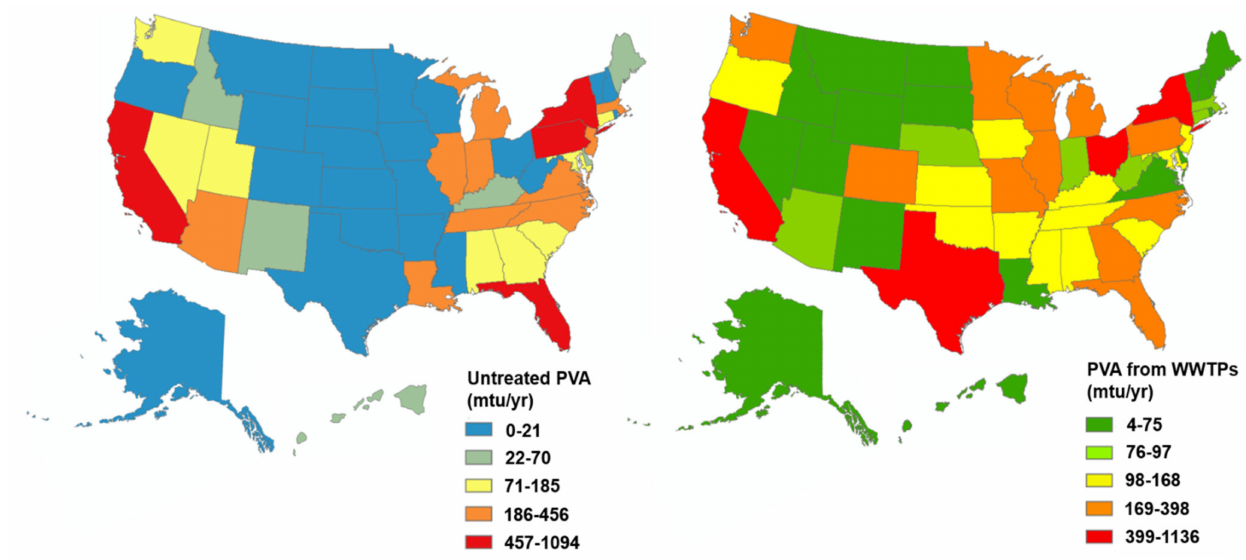
Figure 3. PVA emissions across the U.S. in mtu/yr. The left panel is the spatial distribution of untreated PVA via wastewater that does not reach the treatment plants. The right panel represents the PVA from WWTP effluent streams, including aqueous and sludge disposal